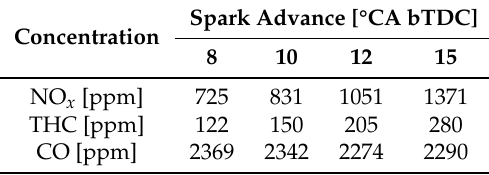
Table 1. Mean engine raw emissions as a function of the spark advance for first 30s after start of ignition.